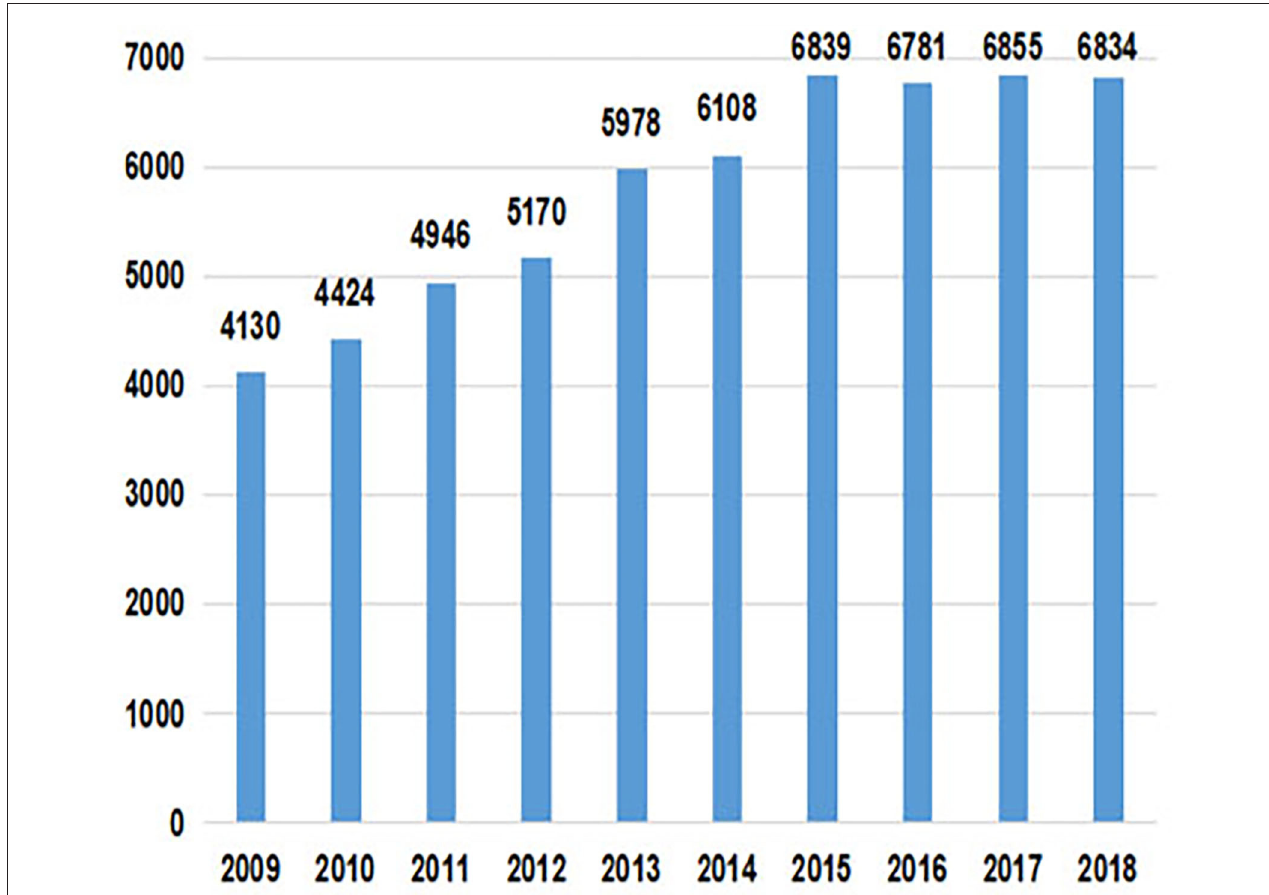
FIGURE 1 | Total number of publications of health policy and services from 2009 to